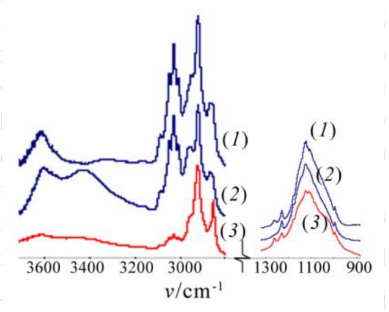
Figure 6. IR spectra of products 3.1 , 4 , and 5 : ( 1 ) 3.1 , ( 2 ) 4 , and ( 3 ) 5 .